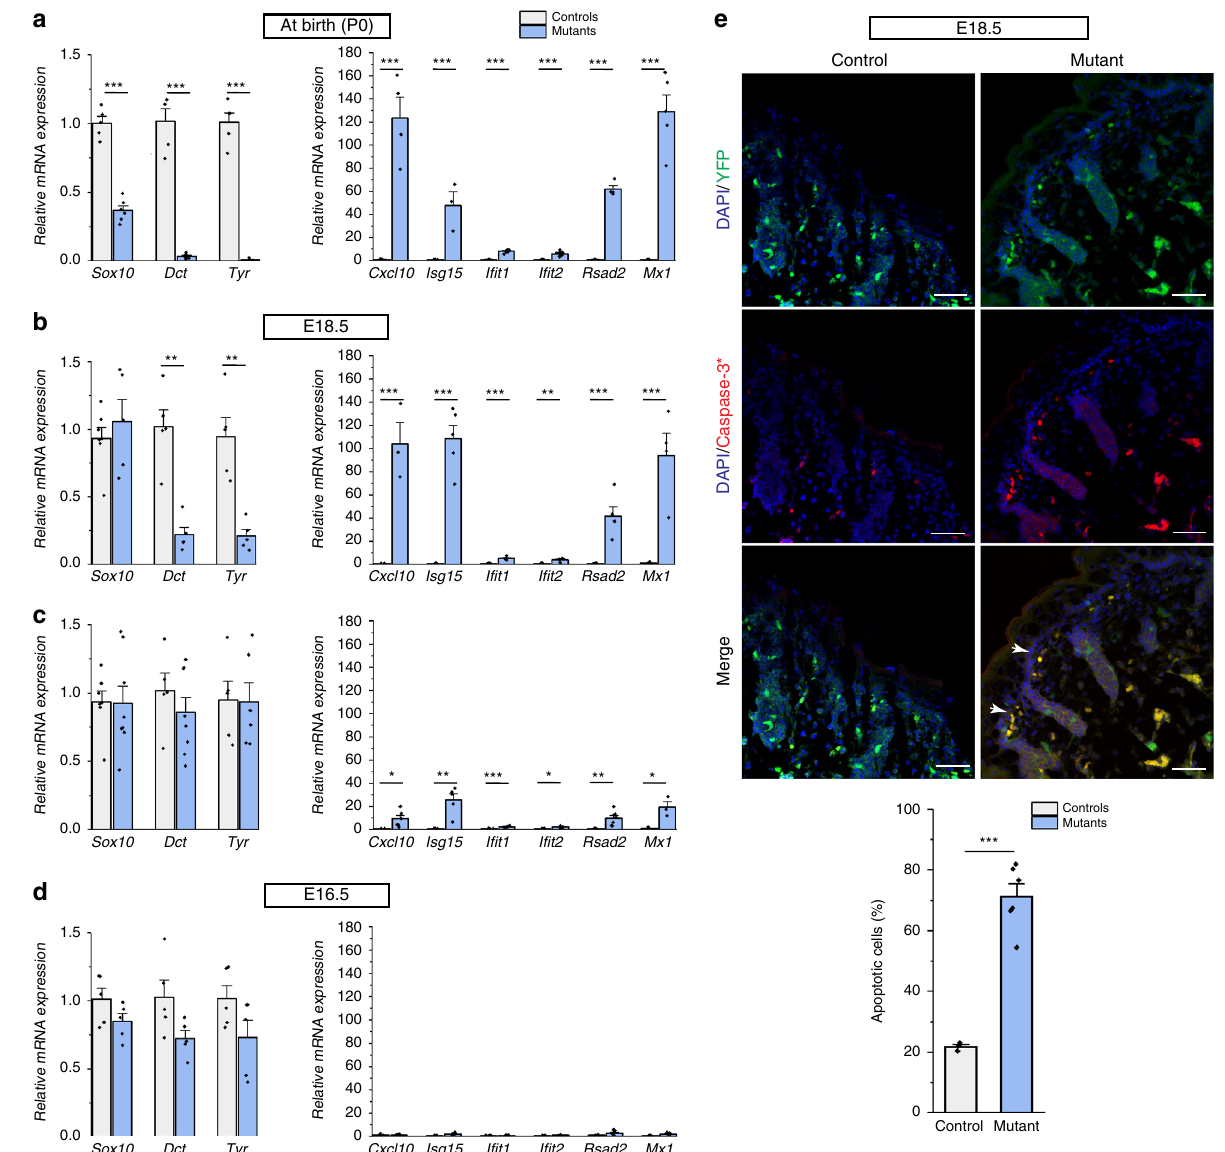
Fig. 3 ADAR1 activity is required to control the survival of melanocytes from E18.5. a – d Analysis of the expression of melanocytes differentiation genes ( Sox10, Dct, Tyr ) and Interferon-stimulated genes (ISG signature composed of Cxcl10, Isg15, I fi t1, I fi t2, Rsad2, Mx1 ) in the skin of controls (gray) and HtPA- Cre; Adar1 fl / fl mutants (blue) at a P0, b , c E18.5 (note that we found mutant embryos of the two categories within the same litter) and d E16.5, by RT-qPCR. All data represent mean ± SEM. Statistical differences between the groups (for a n = 4 controls and n = 3 – 6 mutants depending on tested genes; for b n = 5 controls and n = 4 or 5 mutants depending on tested genes; for c n = 4 or 5 controls and n = 4 – 8 mutants depending on tested genes; for d n = 5 or 8 controls and n = 5 or 8 mutants depending on tested genes) were determined using t test (asterisks represent p values: *p < 0.05, **p < 0.01, ***p < 0.001). e YFP (green) and activated-caspase 3 (red) immunostaining on skin sections of control and HtPA-Cre; Adar1 fl / fl mutant mice at E18.5 (white arrowheads indicate apoptotic cells) and quanti fi cation of caspase-3-positive cells among YFP cells (%). Data represent mean ± SEM, and statistical differences between the groups ( n = 3 controls, gray and n = 6 mutants, blue) was determined using t test (asterisks represent p value: ***p < 0.001). Counterstaining with DAPI (blue) is shown to identify structures. Scale bar: 50 μ m. For all panels, source data are provided as a source data fi